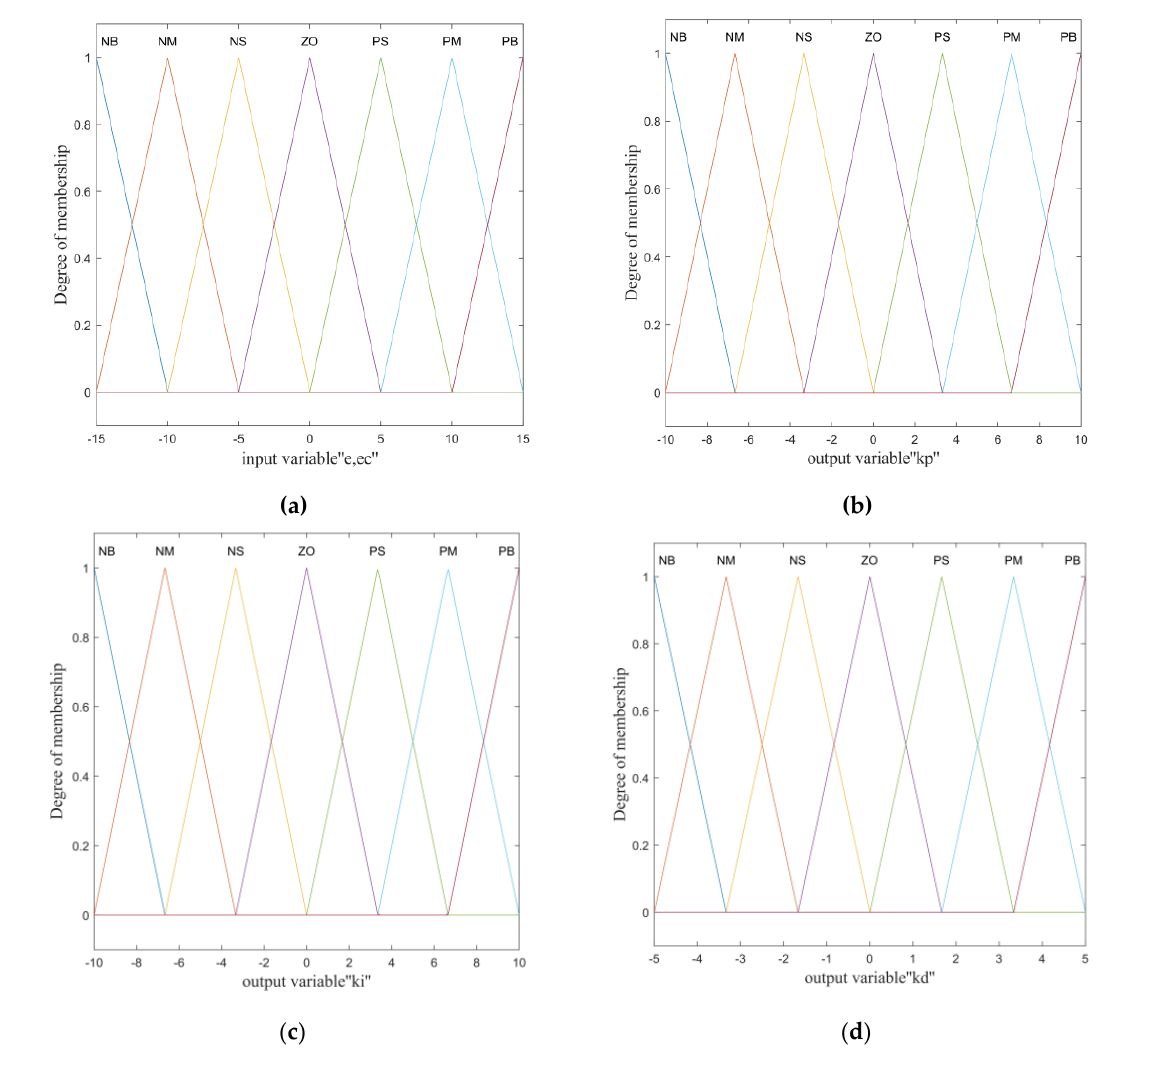
Figure 8. The membership function curves of two input variables and three output variables: ( a )